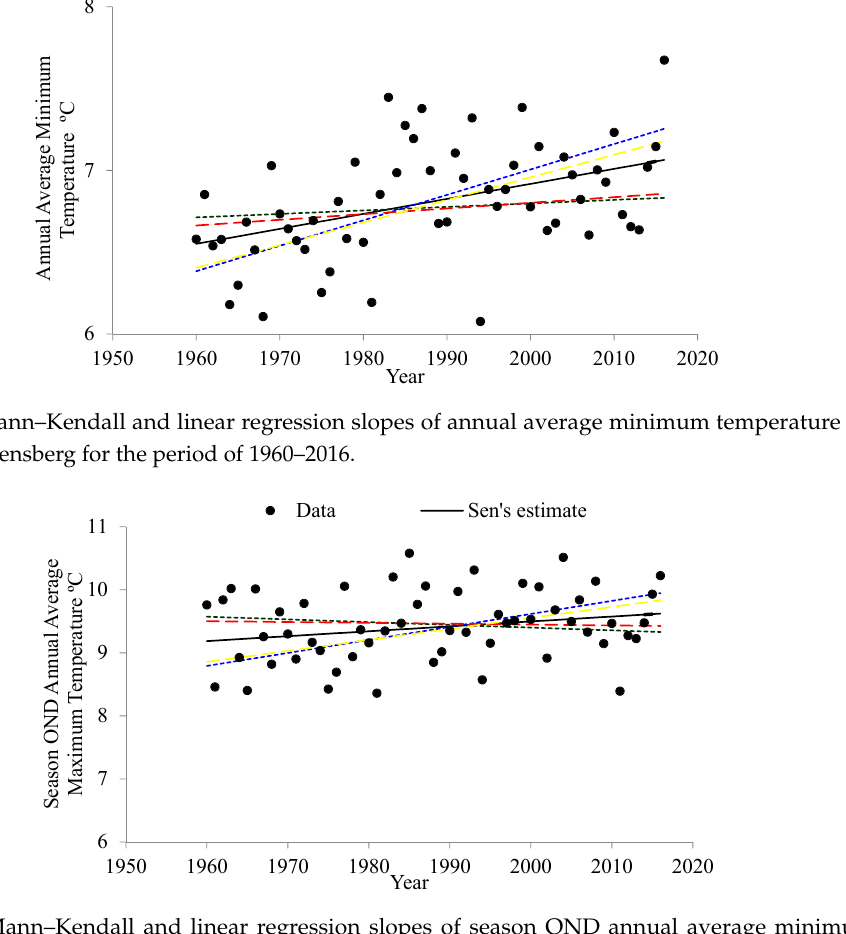
Figure 9. Mann–Kendall and linear regression slopes of season OND annual average minimum temperature for Maloti-Drakensberg for the period of 1960–2016.